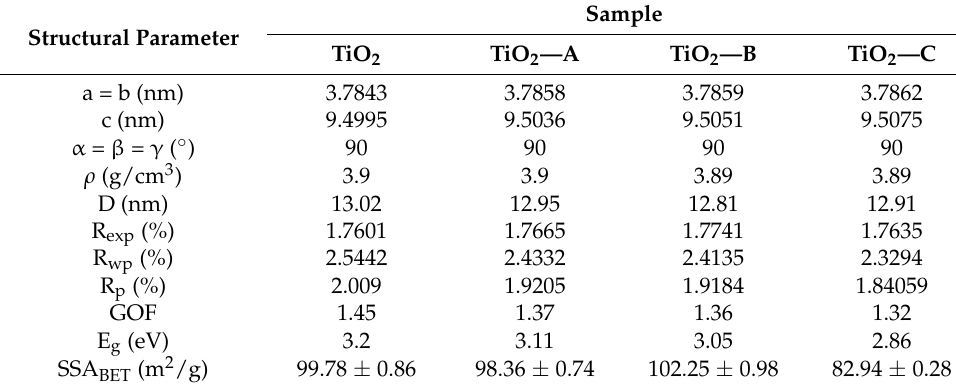
Table 1. Structural parameters of iron-doped TiO 2 nanoparticles.